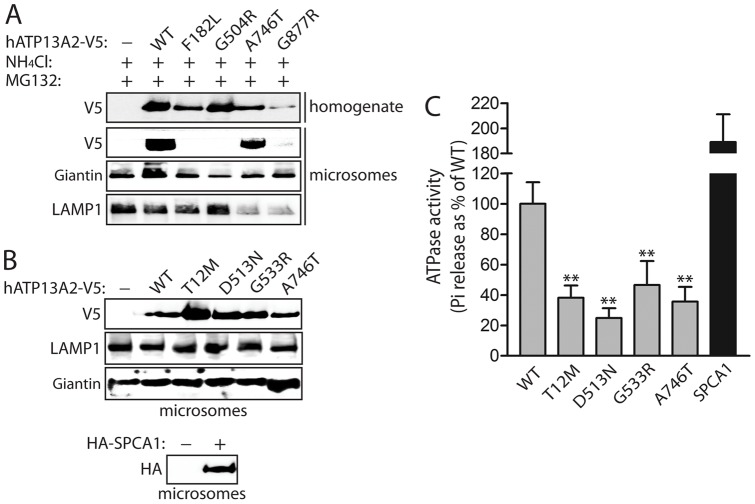
Heterozygous missense mutations impair the ATPase activity of ATP13A2.
A, Microsomal fractions prepared by ultracentrifugation from HEK-293T cells transiently expressing V5-tagged human ATP13A2 variants (or empty vector control) following treatment for 24 hours with 5 µM MG132 and 50 mM NH4Cl to inhibit proteasomal and lysosomal degradation. Microsomes or total homogenates were probed with anti-V5 antibody to monitor ATP13A2 levels, or with anti-LAMP1 and anti-Giantin antibodies to detect enrichment of lysosomal and Golgi membranes, respectively. Homozygous mutants (F182L, G504R and G877R) fail to localize to microsomes. B, Microsomal fractions from HEK-293T cells expressing WT or mutant V5-tagged ATP13A2 or HA-tagged human SPCA1 were probed with anti-V5 or anti-HA antibodies to monitor each protein variant, or with anti-LAMP1 and anti-Giantin antibodies to detect membranes. C, ATP hydrolysis activity of ATP13A2 variants or SPCA1 was determined in microsomal fractions by measuring the concentration of free phosphate (Pi) released from ATP. The levels of ATP13A2 in each microsomal fraction were assessed by Western blot analysis with anti-V5 antibody, quantified by densitometry, and used for normalization of Pi release between ATP13A2 variants. ATP hydrolysis activity is expressed as Pi release as a percent of WT ATP13A2 activity. Bars represent the mean±SEM (n = 4 experiments). **P<0.01 compared to WT ATP13A2 by one-way ANOVA with Newman-Keuls post-hoc analysis.